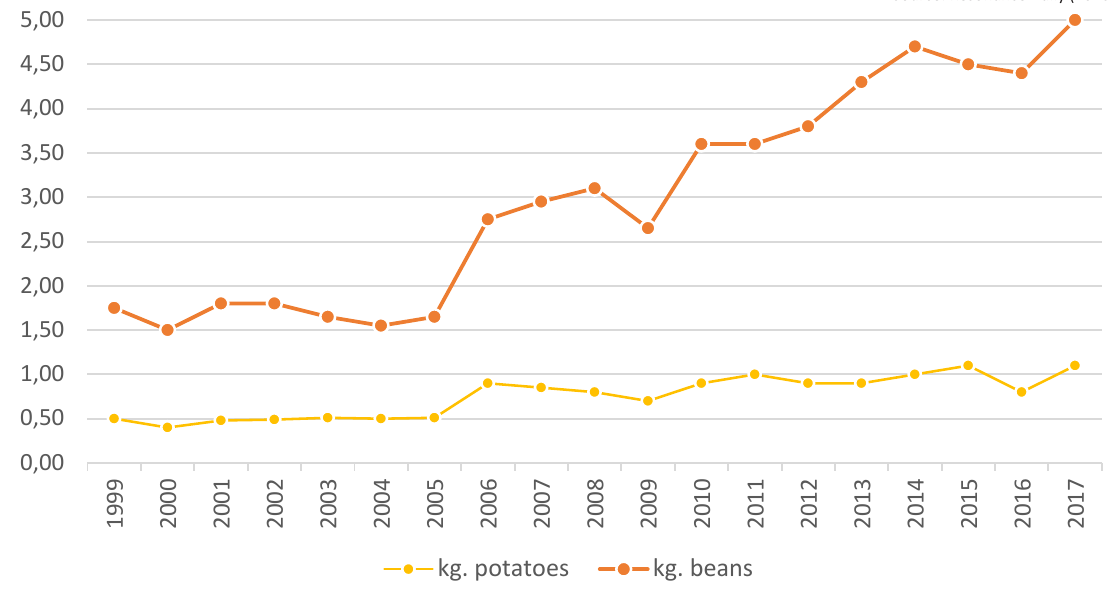
Figure 6. Dynamics of vegetable prices in